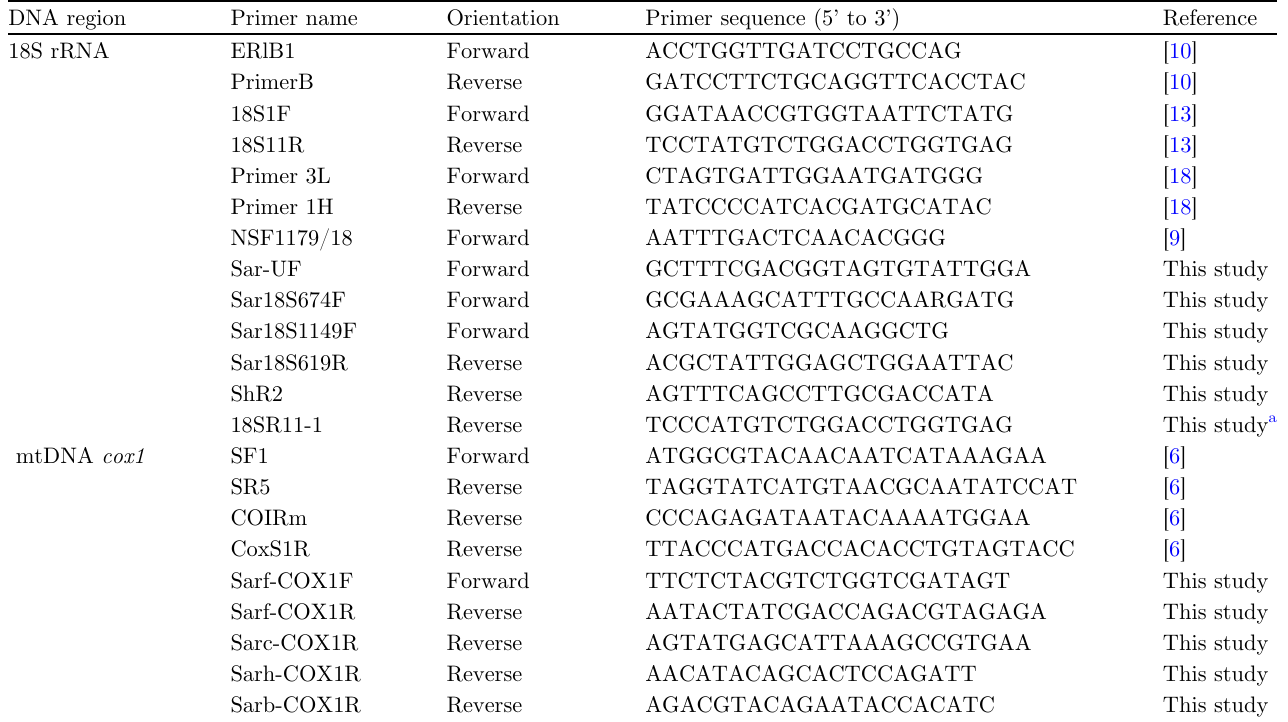
Table 3. Oligonucleotide primers used for PCR. DNA